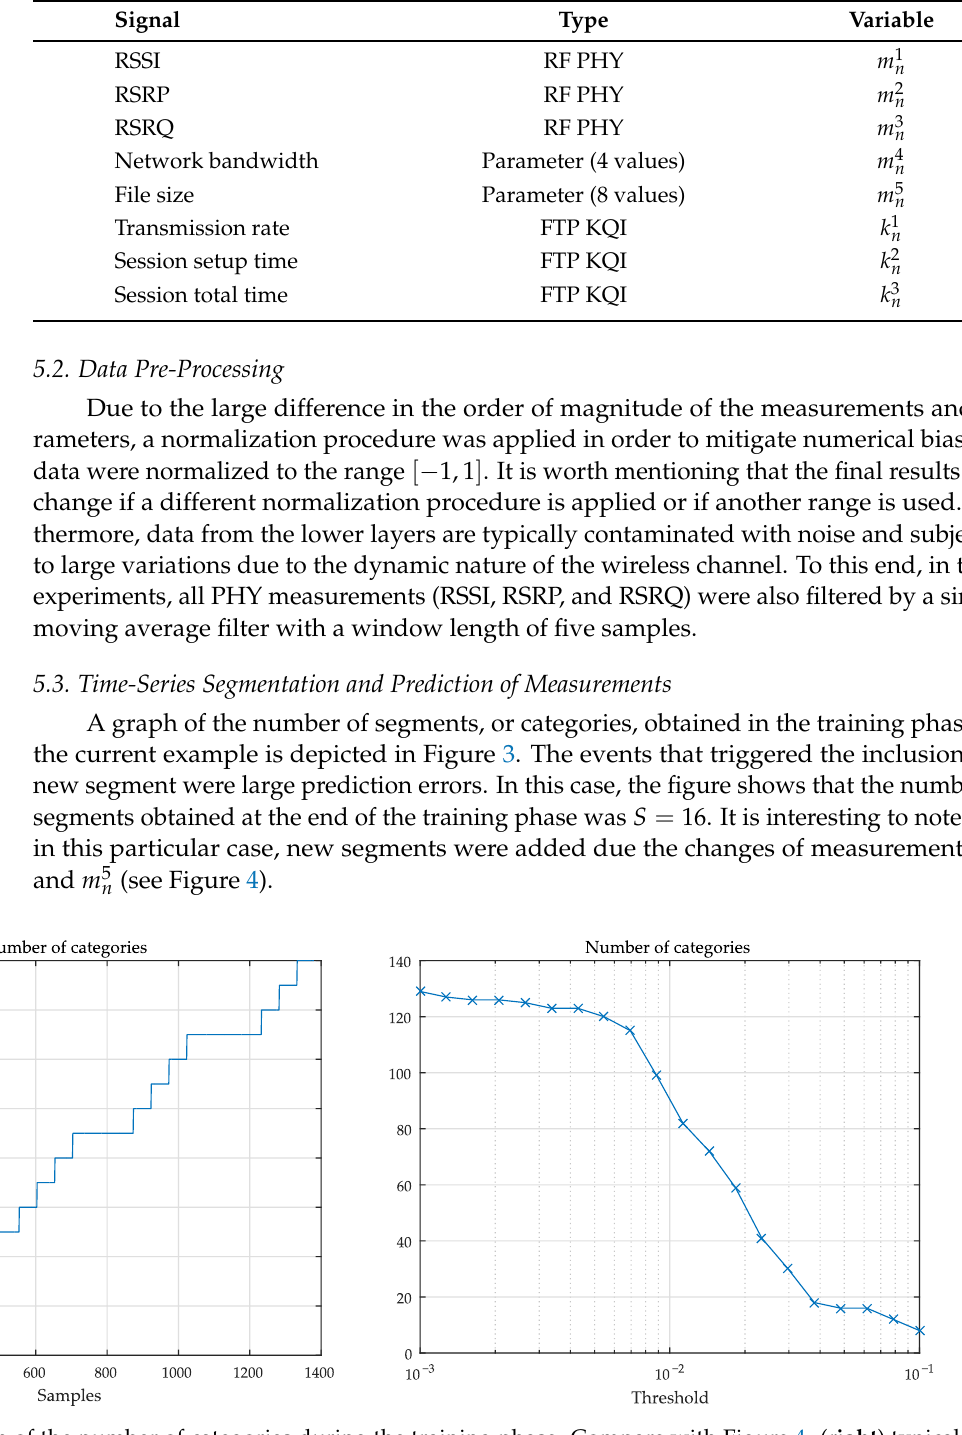
Figure 3. ( left ) evolution of the number of categories during the training phase. Compare with Figure 4. ( right ) typical behavior of the number of categories as a function of γ MAX